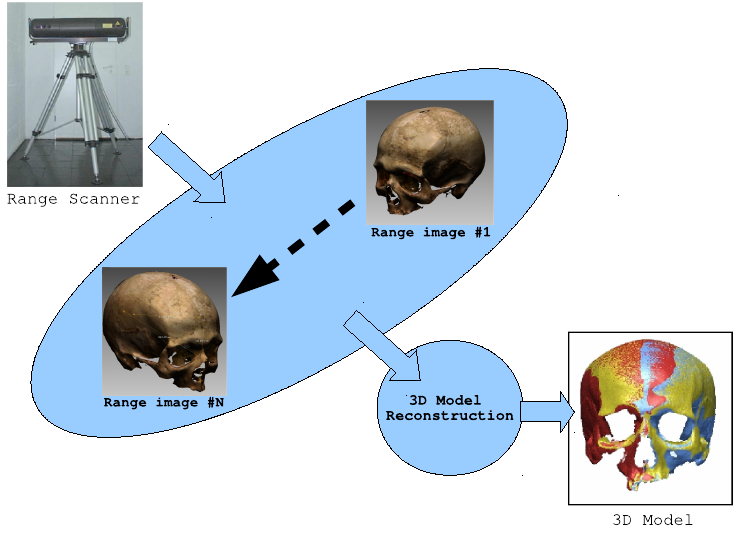
Figure 2. The 3D model reconstruction